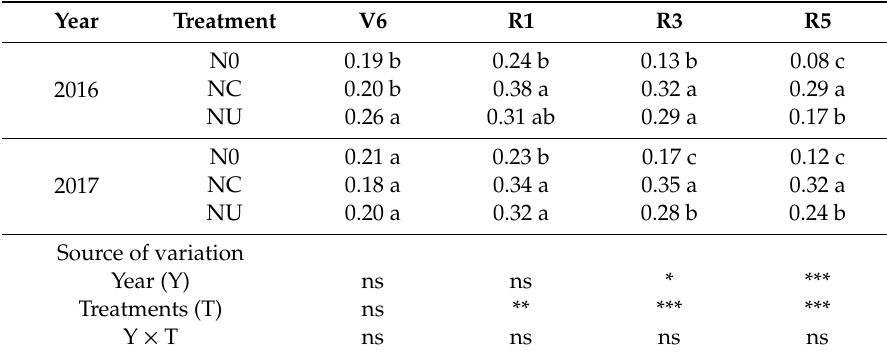
Table 1. E ff ects of N application treatments on total root length density (cm cm − 3 ) in 0–60 (at six leaf stage (V6)) and 0–100 cm (at silking stage (R1), milking stage (R3), and dent stage (R5)) soil layers during the entire growing season in 2016 and